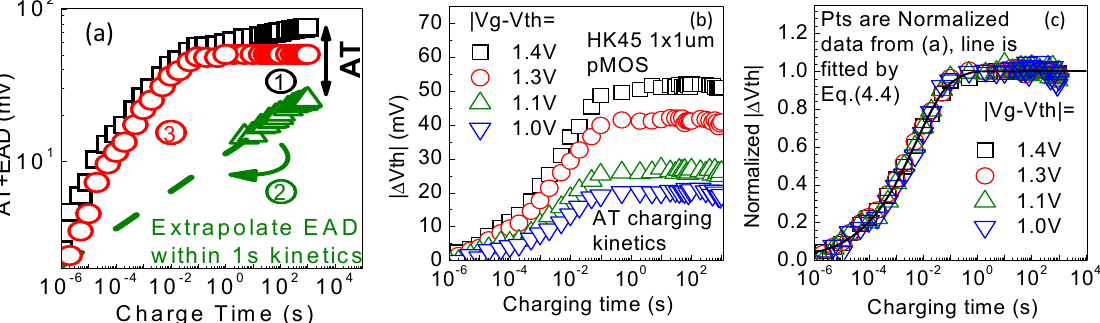
Figure 18. ( a ) Separating AHTs from EADs. The saturation level of AHT was first subtracted from the total Δ Vth (“ □ ”) to give the EAD (“ Δ ”). The EAD was then fitted with a power law and extrapolated over the short term (see dashed line). The AHT (“o”) was obtained by subtracting the green dashed line from the total Δ Vth (“ □ ”). ( b ) The AHT kinetics at different charging biases. A higher charging |Vg − Vth| gives a higher AHT. ( c ) The AHT kinetics normalized against its saturation level [37]. Filling EADs at different Vgov is shown in Figure 19a. Figure 19b shows that the extracted time power exponent is insensitive to Vgov, and Figure 19c shows that EADs also follow a power law against Vgov.